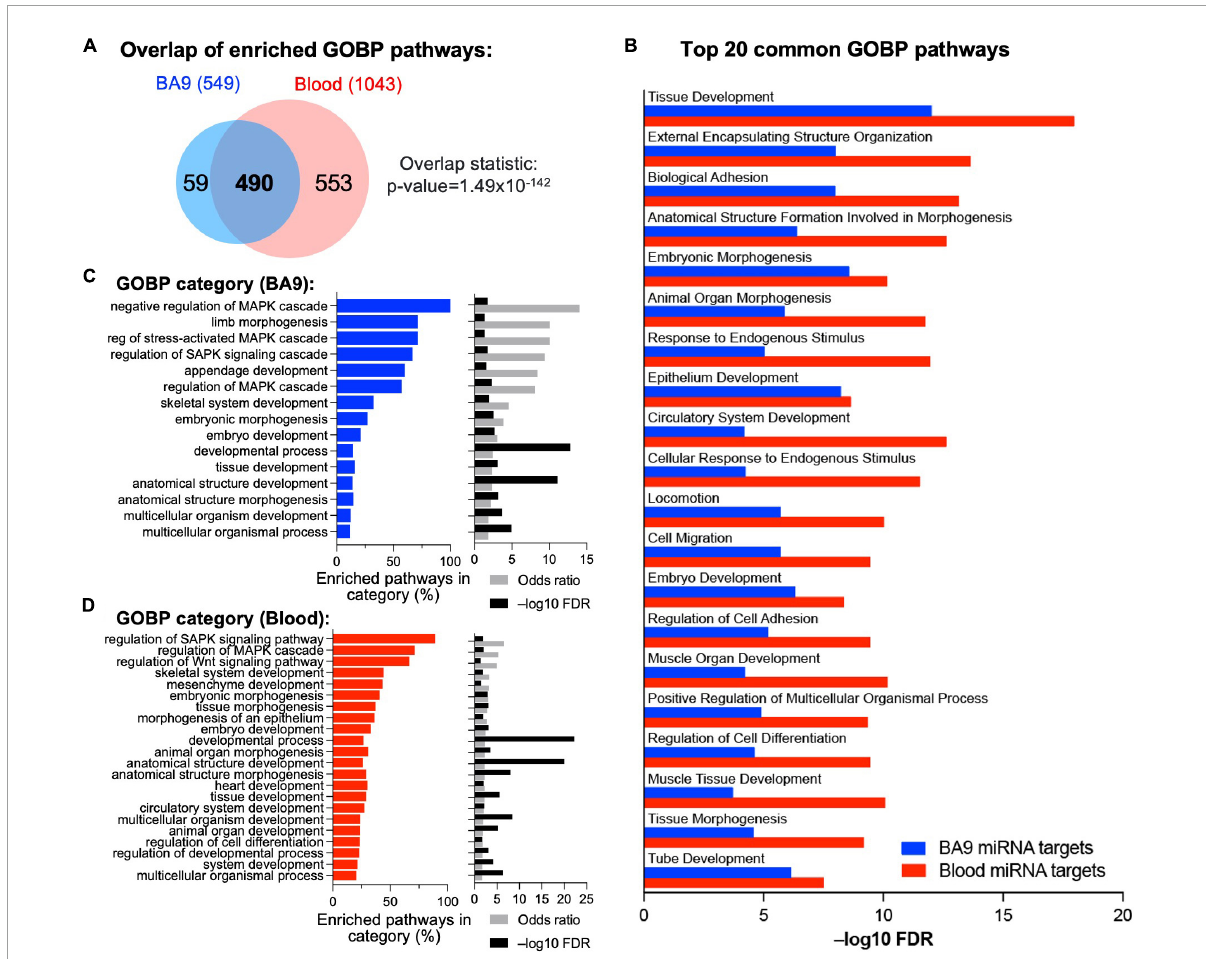
FIGURE4 Integrative analysis of miRNA–mRNA networks. (A) Pathway enrichment was carried out with the enriched gene targets of BA9 and blood miRNAs using the Gene Ontology Biological Processes compendium, with overlap of enriched pathways shown as a Venn diagram. (B) Top 20 common GOBP pathways between BA9 and blood miRNA targets. (C) List of GO terms enriched in the 549 significant pathways in BA9 miRNA targets. (D) List of GO terms enriched in the 1,043 pathways significant in blood miRNA targets. For panels (C,D) , the percent of pathways associated with a GO term, odds-ratio, and –log10(FDR) are